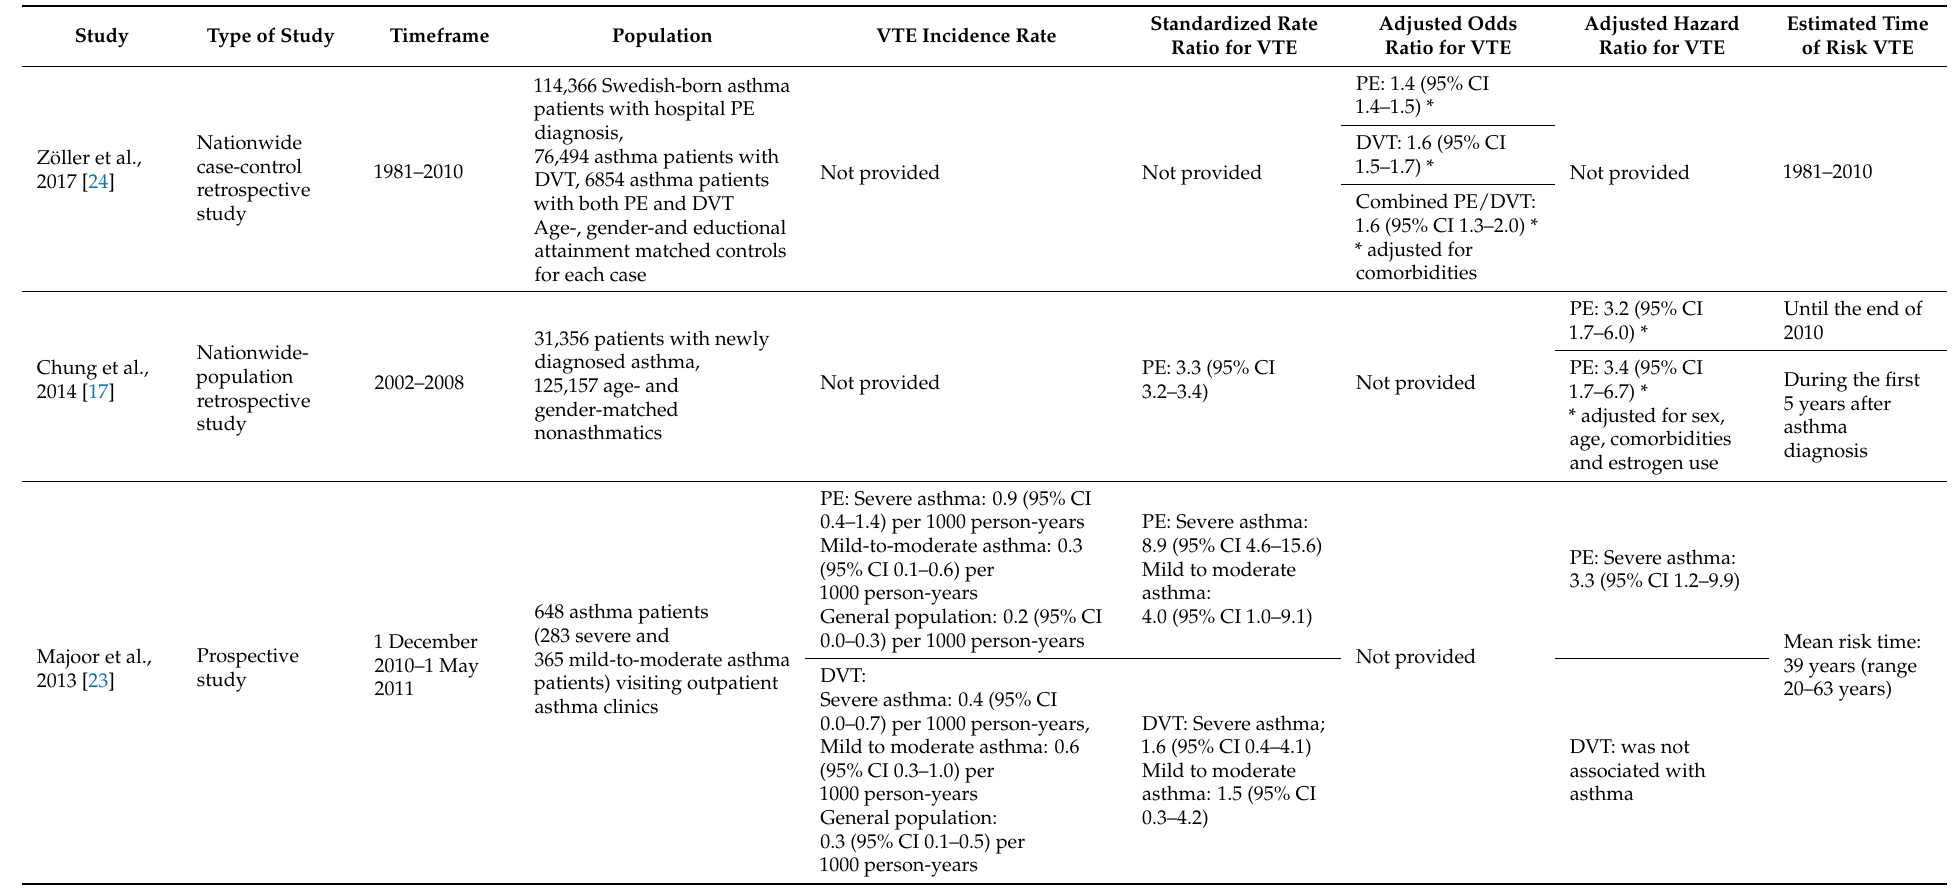
Table 1. Characteristics of studies included in this review regarding the relationship between asthma and venous thromboembolic disease